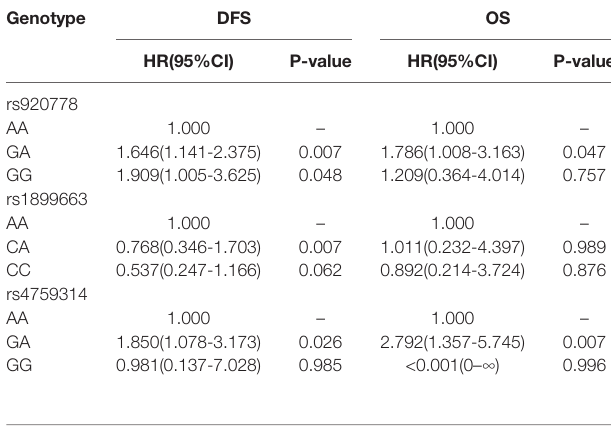
TABLE 7 | HR in different genotypes of HOTAIR SNPs in univariate Cox regression